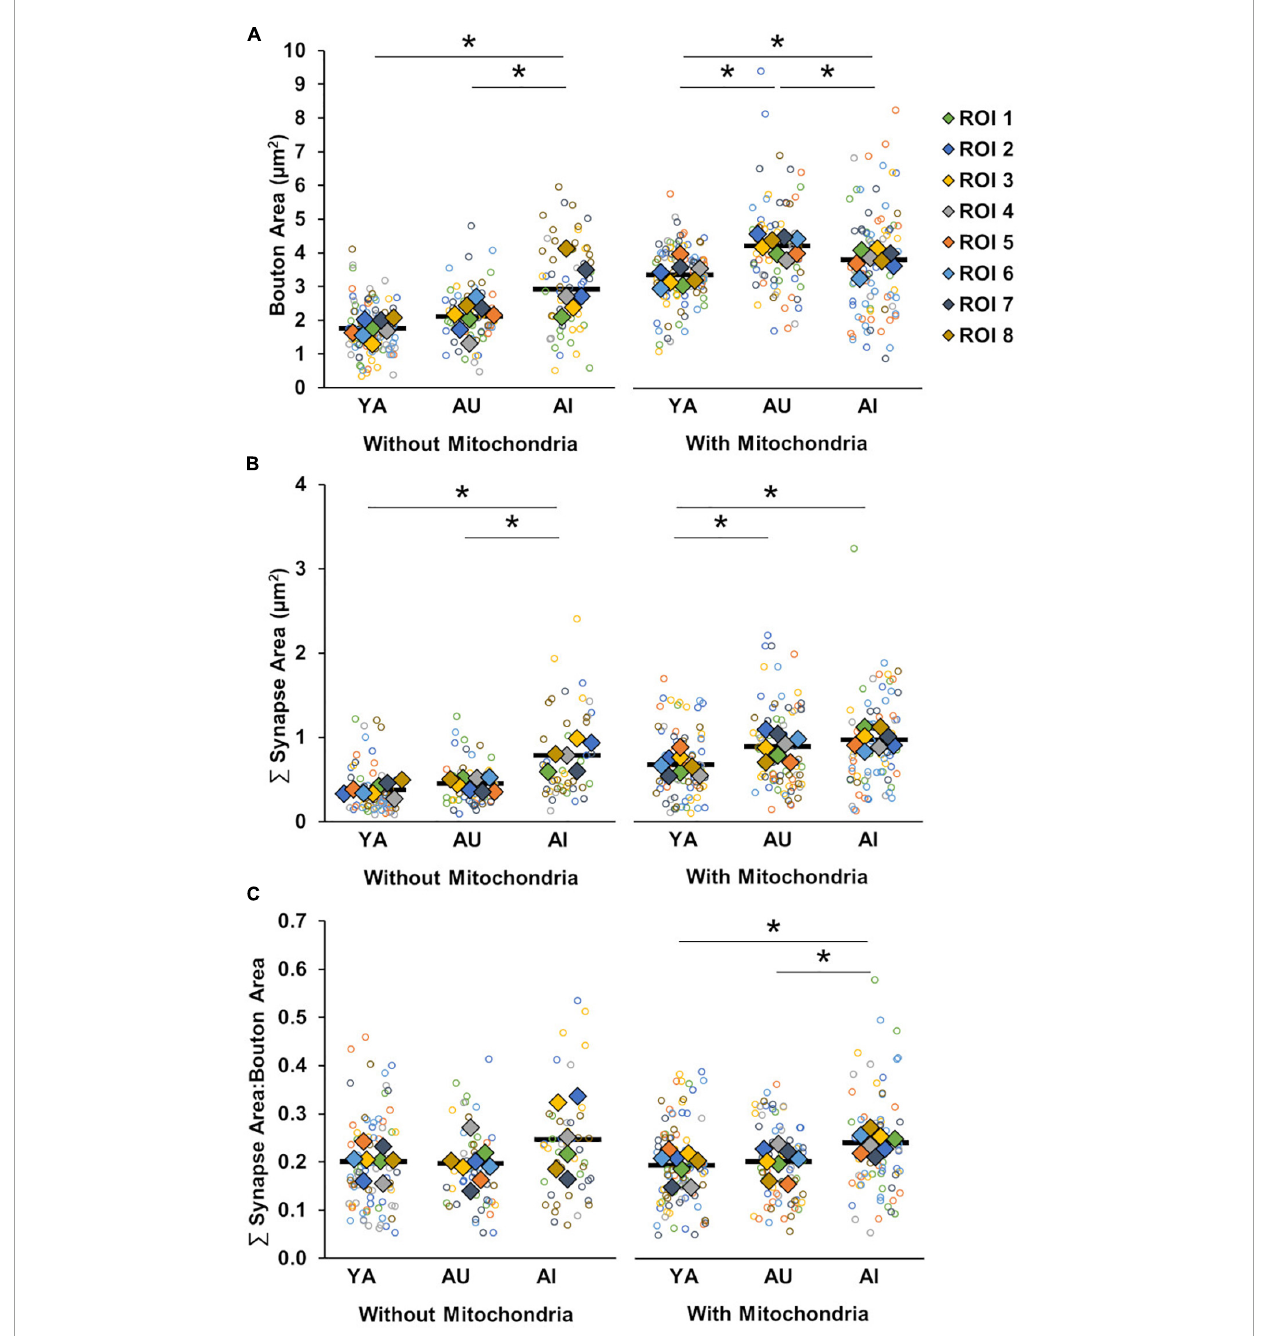
FIGURE5 Boutons and synapses with and without mitochondria. (A) Bouton size by absence or presence of presynaptic mitochondria. Boutons without presynaptic mitochondria were larger in AI compared to YA and AU. Boutons with presynaptic mitochondria were larger in both aged marmosets than the young, with further enlargement in AU compared to AI. (B) Summed synapse surface area by absence or presence of presynaptic mitochondria. Synapses without associated presynaptic mitochondria were larger in AI compared to YA and AU, while synapses with associated presynaptic mitochondria were larger in aged marmosets, regardless of cognitive status. (C) Ratio of synapse surface area to bouton area by absence or presence of presynaptic mitochondria. The ratio of synapse size to bouton size is significantly larger in the AI marmoset compared to YA and AU only when presynaptic mitochondria were present. Open circles show each individual data point, colored diamonds represent the average of measures taken in each of the ROIs, and horizontal black bars represent average across the ROIs. * p < 0.05.